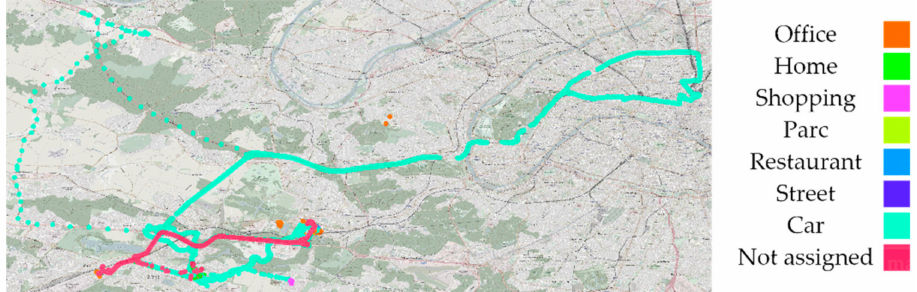
Figure 6. Spatial tracing of activity annotations for both periods A and B.